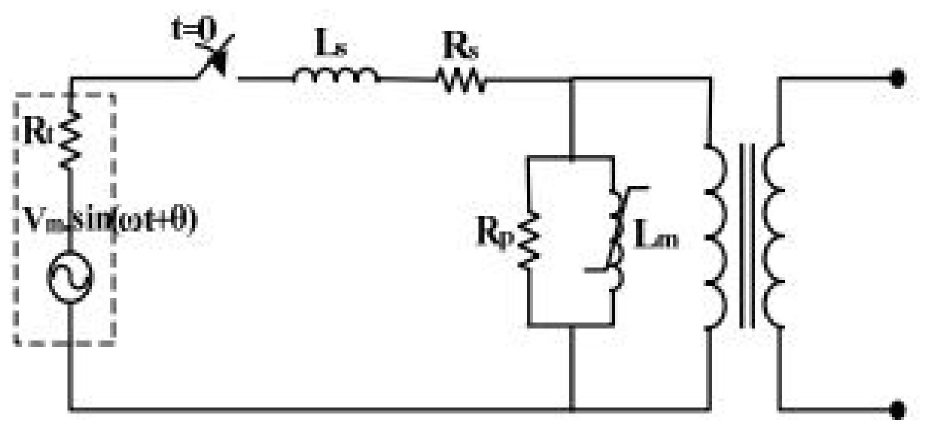
Figure 4. Consider R s , R p , and R t are a series, core losses and source resistances and L s and L m are series and magnetizing inductances, respectively.